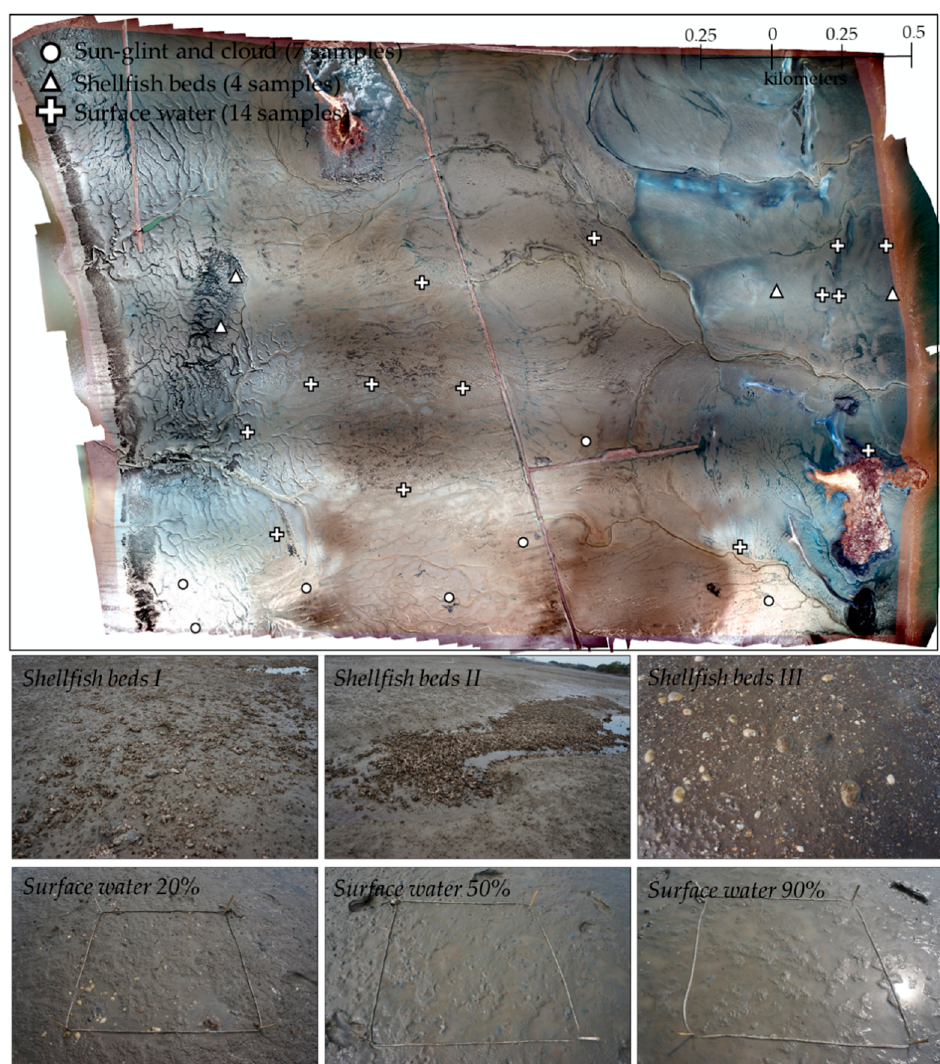
Figure 7. Overview of misclassified samples on tidal flat of Hwang-do, imaged by UAV orthoimage and the corresponding in situ photographs. The circles are affected by sun-glint and cloud. The triangles are misclassified samples due to shellfish beds. The crosses indicate that the misclassified samples are affected by surface water.